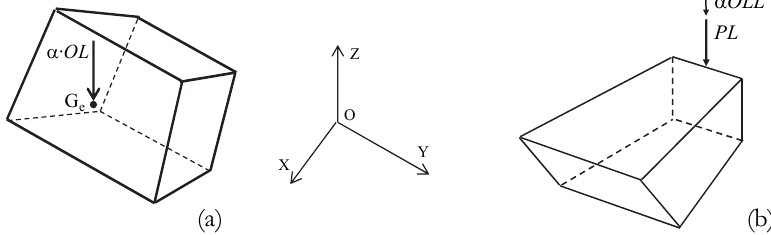
Figure 4: (a) The overload acting on the dome, increasing through an α multiplier  (b) The force on the block on top corresponding to one sixteenth of the lantern own weight, together with the overload (which also increases through α  acting to the small dome of the